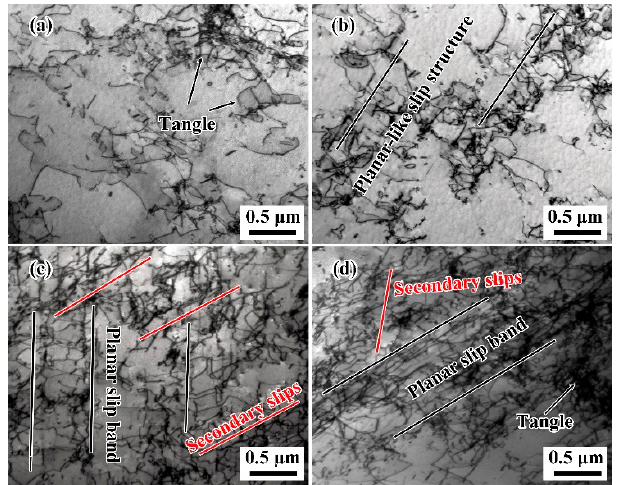
Figure 4. TEM images of dislocation structures of Cu–Ni alloys containing 5 at.% Ni ( a ), 10 at.% Ni ( b ), and 20 at.% Ni ( c , d ) uniaxially compressed up to a true strain of 5%.